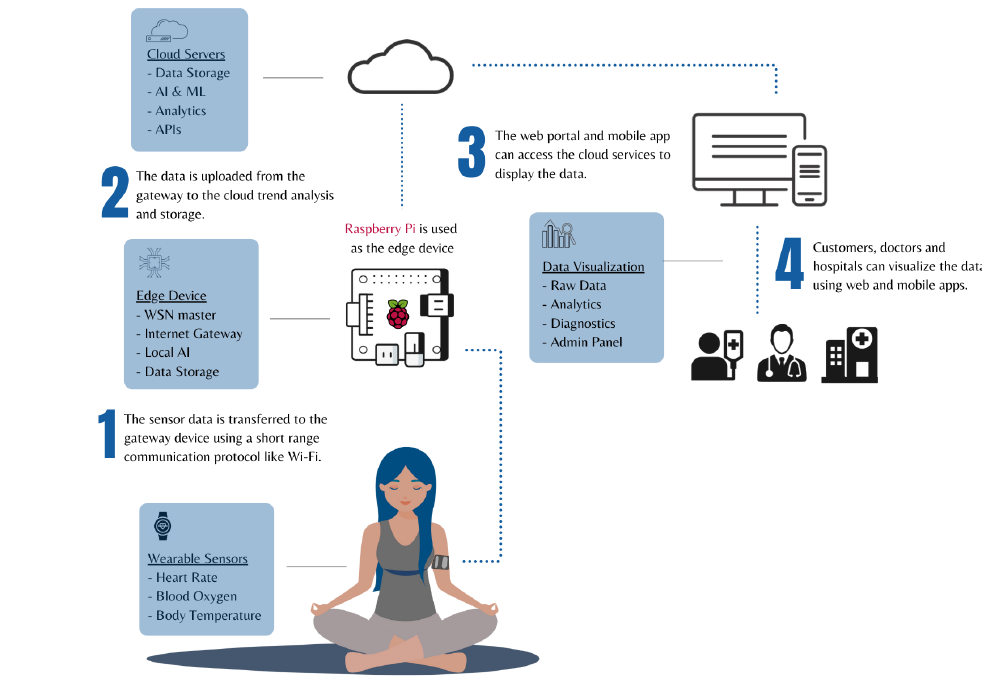
Figure 1. Proposed System